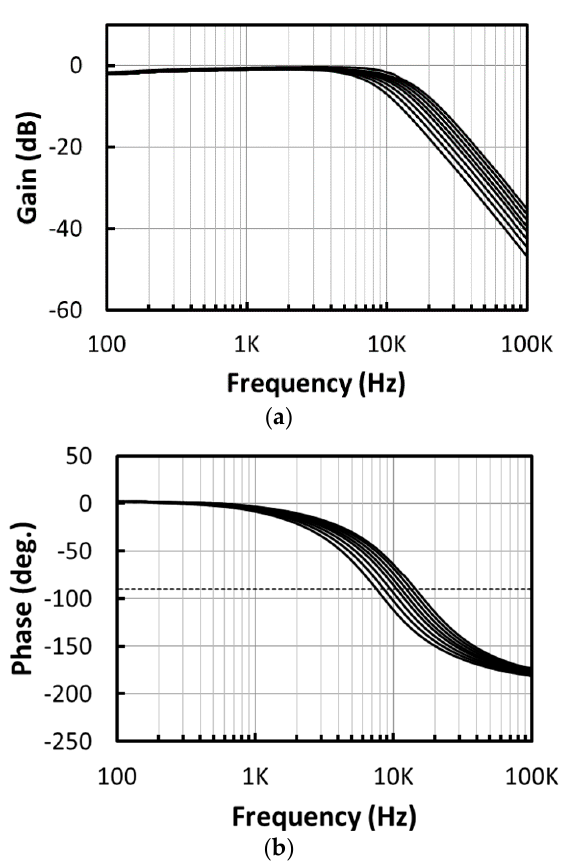
Figure 16. The measured ( a ) gain and ( b ) phase frequency responses of the LPF.